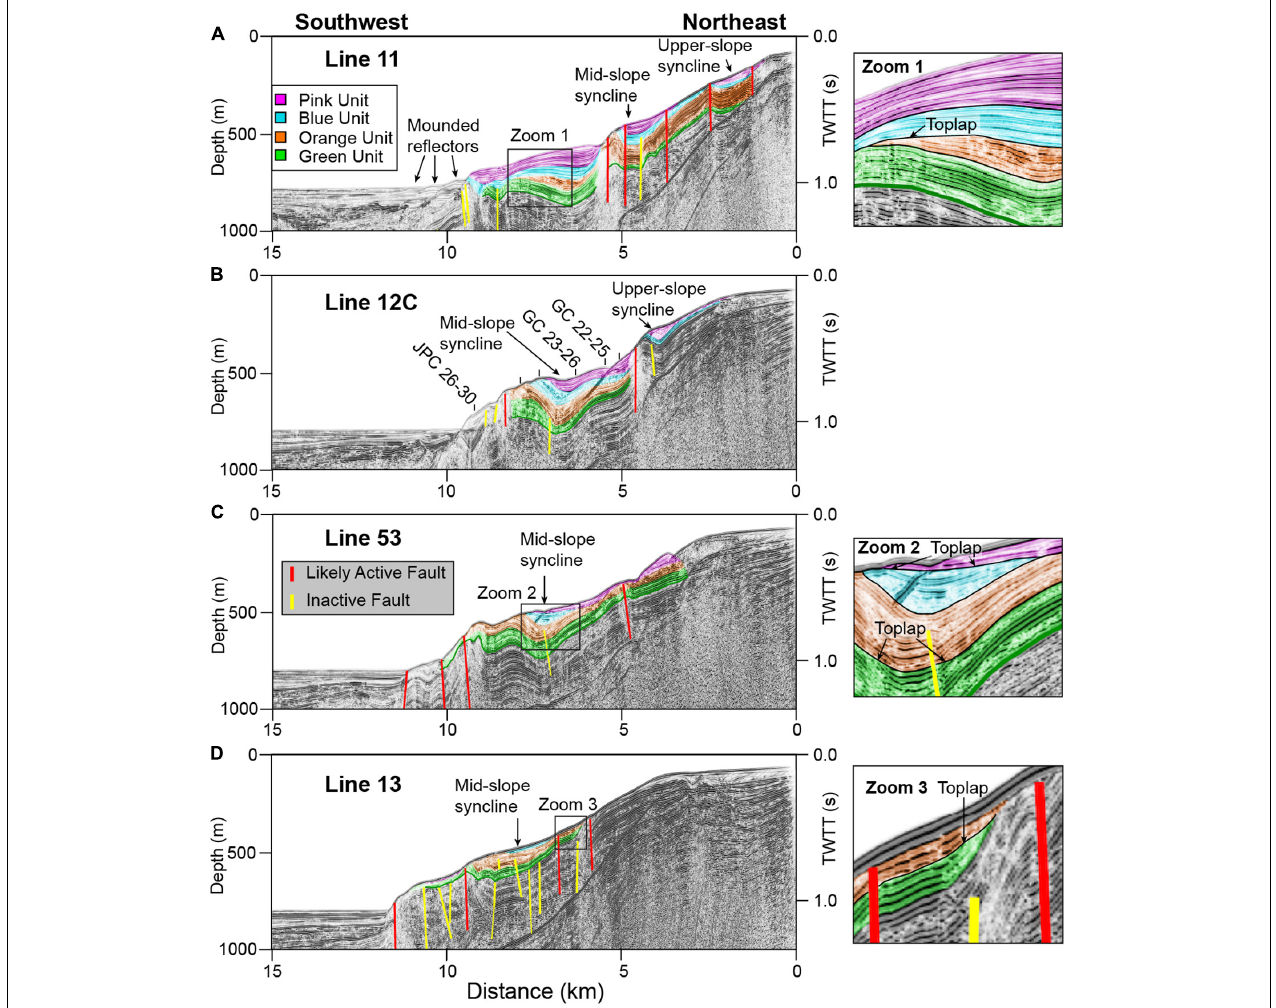
FIGURE 5 | Sparker seismic dip profiles offshore San Onofre reveal the internal structure of the slope and are organized with the northernmost profile at the top and southernmost profile at the bottom. (A) Line 11 is located northwest of the SON canyon, (B) Line 12C intersects the SON canyon, (C) Line 53 intersects the SOS canyon, and (D) Line 13 is southeast of the SOS canyon. The continental slope is characterized by a mid-slope syncline that decreases gradient that is bound by anticlines that increase gradient. Lines 11 and 12C contain upper slope synclines. The mid- and upper-slope synclines act as ponded basins that trap sediment. Mounded features are shown at the slope-basin transition in Line 11. Colors of Units are shown in panel A . Active faults offset reflectors just below the seafloor are shown in red. Inactive faults offset deeper reflectors and are shown in yellow. Sediment cores are projected onto seismic lines. Locations of lines are shown in Figure 1 . At right are enlargements of areas that show toplapping relationships. Vertical Exaggeration = 5.6. For uninterpreted seismic profiles, see Supplementary Figure S2